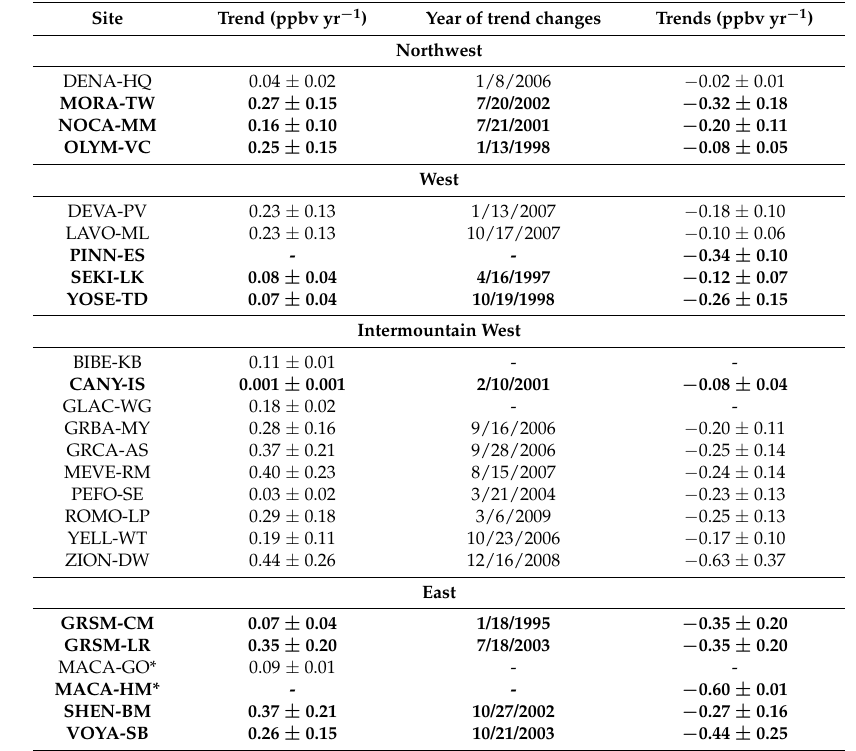
Table 2. Multidecadal ozone trend change (ppbv yr − 1 ) and date of trend changes. The trends in the 2nd and 4th column are the trends before and after the date of trend change, where the dates are indicated in the 3rd column. Sites in bold indicate that trend changes occurred prior to